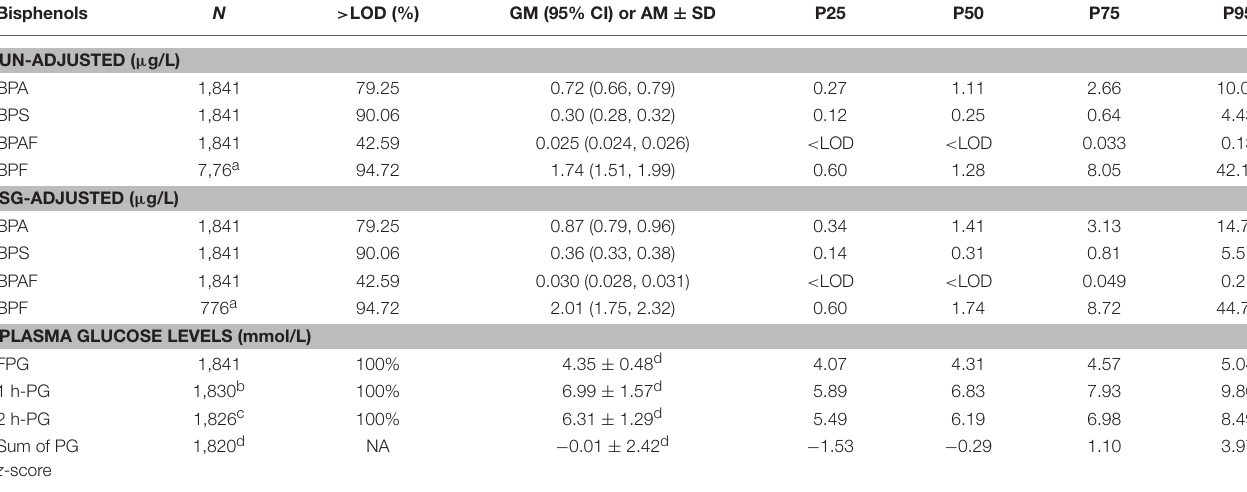
TABLE 2 | Distributions of first-trimester urinary bisphenols concentrations and plasma glucose levels.